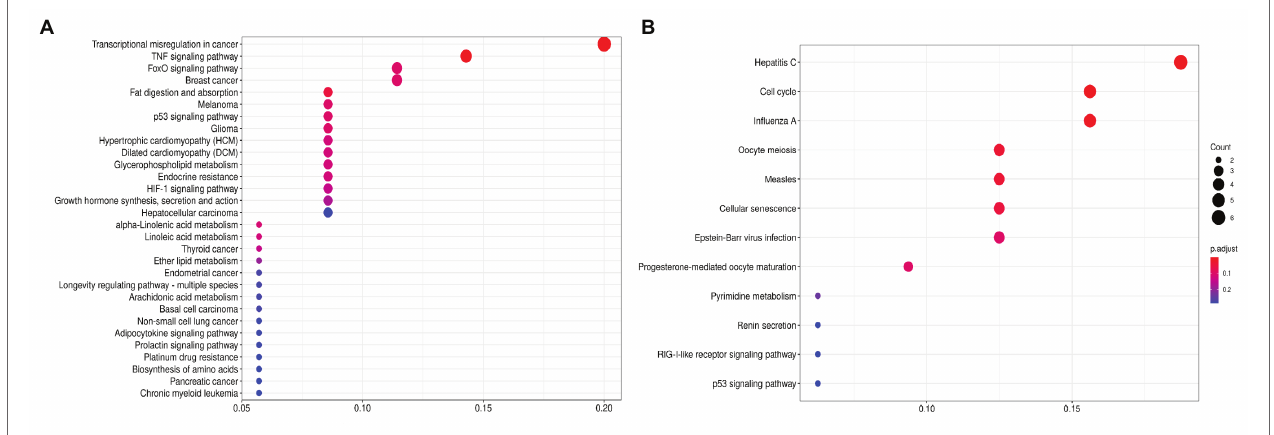
FIGURE 1 | Dotplot showing the results of KEGG pathways enrichment analyses performed for top-80 upregulated (A) and downregulated (B) genes associated with PFS in LAPC. The x -axis indicates k/n ratio (“gene ratio”), where k is the number of genes participating in the current KEGG pathway in the top-80 list and n is the total number of genes that participate this pathway. Dot color indicates the false discovery rate (FDR) values according to the Fisher’s exact test.